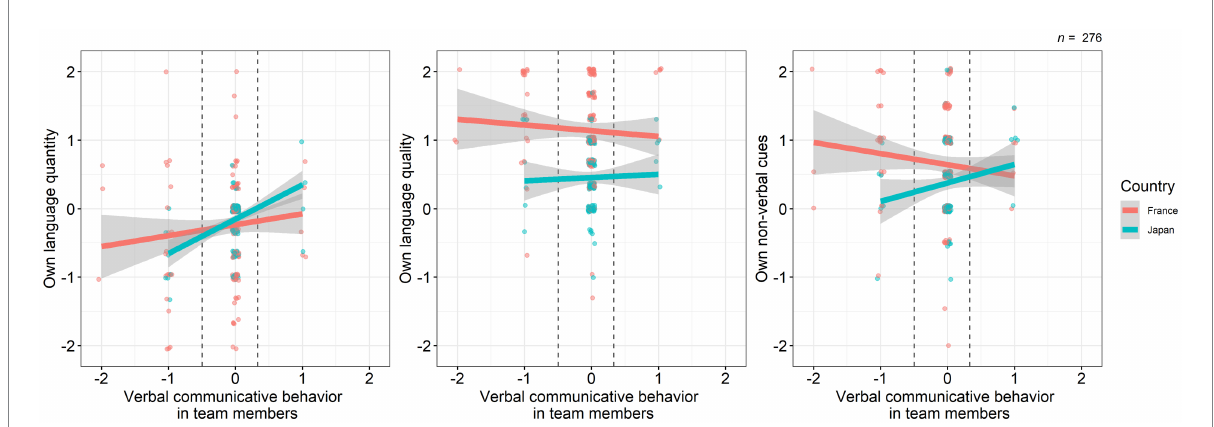
FIGURE 1 The relationship between educators’ own and team members’ communicative behavior. Dot clusters represent individual data points. The lines and gray zones represent the regression lines and 95% confidence intervals, respectively. Dashed lines represent mean ± 1 SD in verbal communicative behavior in team